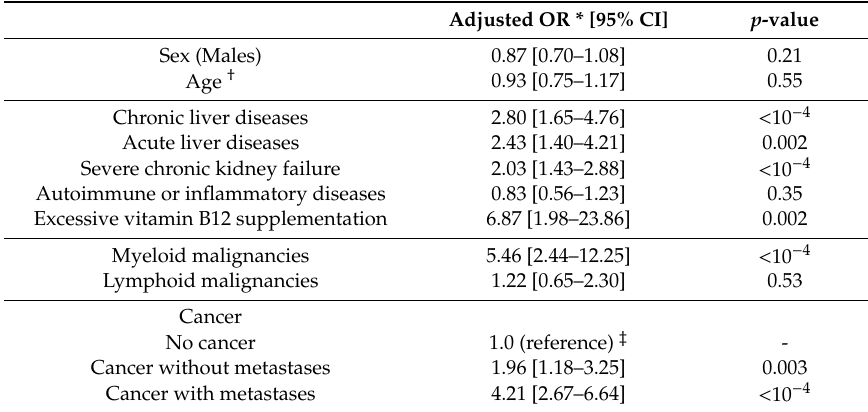
Table 2. Association between a plasma vitamin B12 level ≥ 1000 ng / L and solid cancers with and without metastases in multivariate